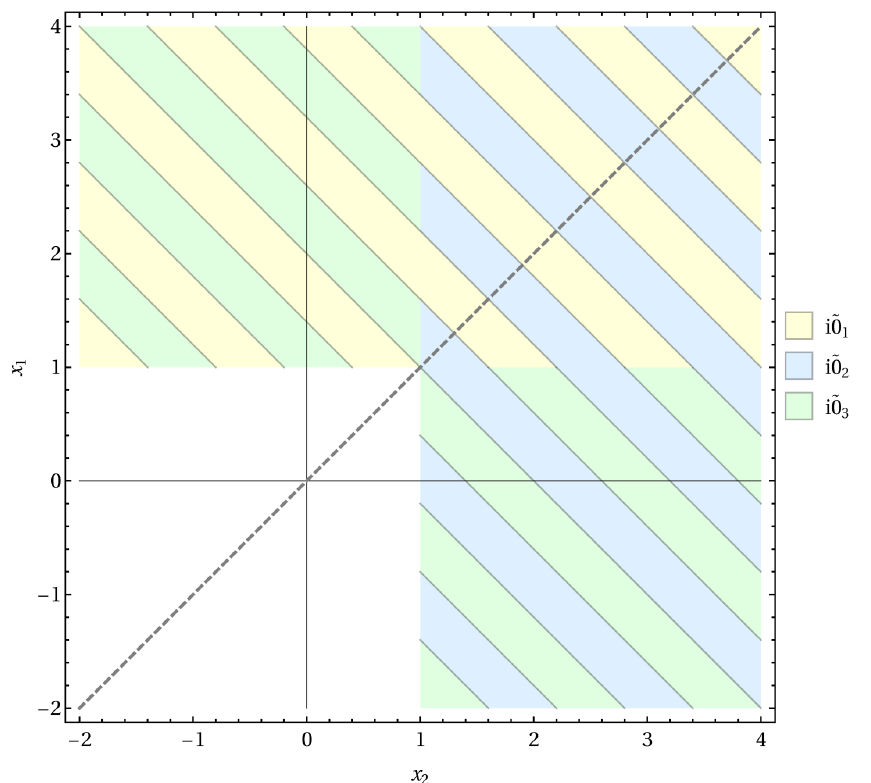
Figure 2 . This plot shows in which kinematic regions the respective imaginary parts i˜0 i of the three logarithms in eq. (2.28) yield a